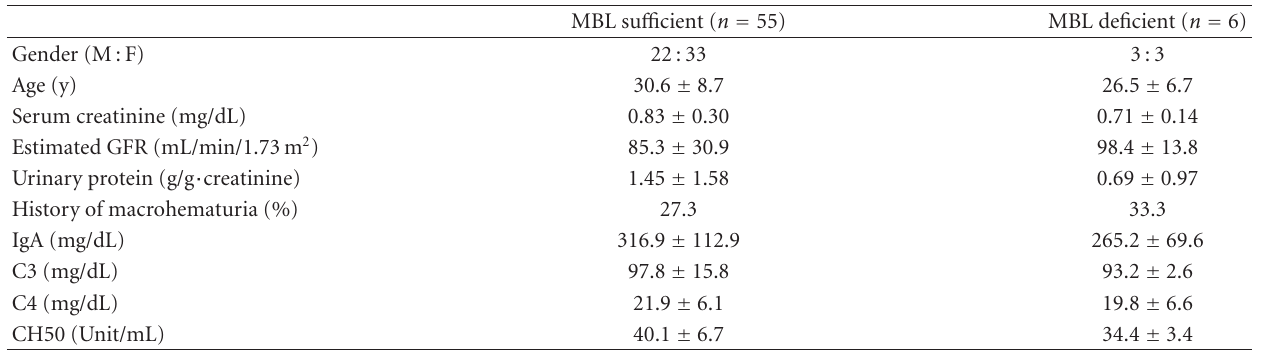
Table 2: Clinical background compared with MBL su ffi cient and MBL deficient of IgA